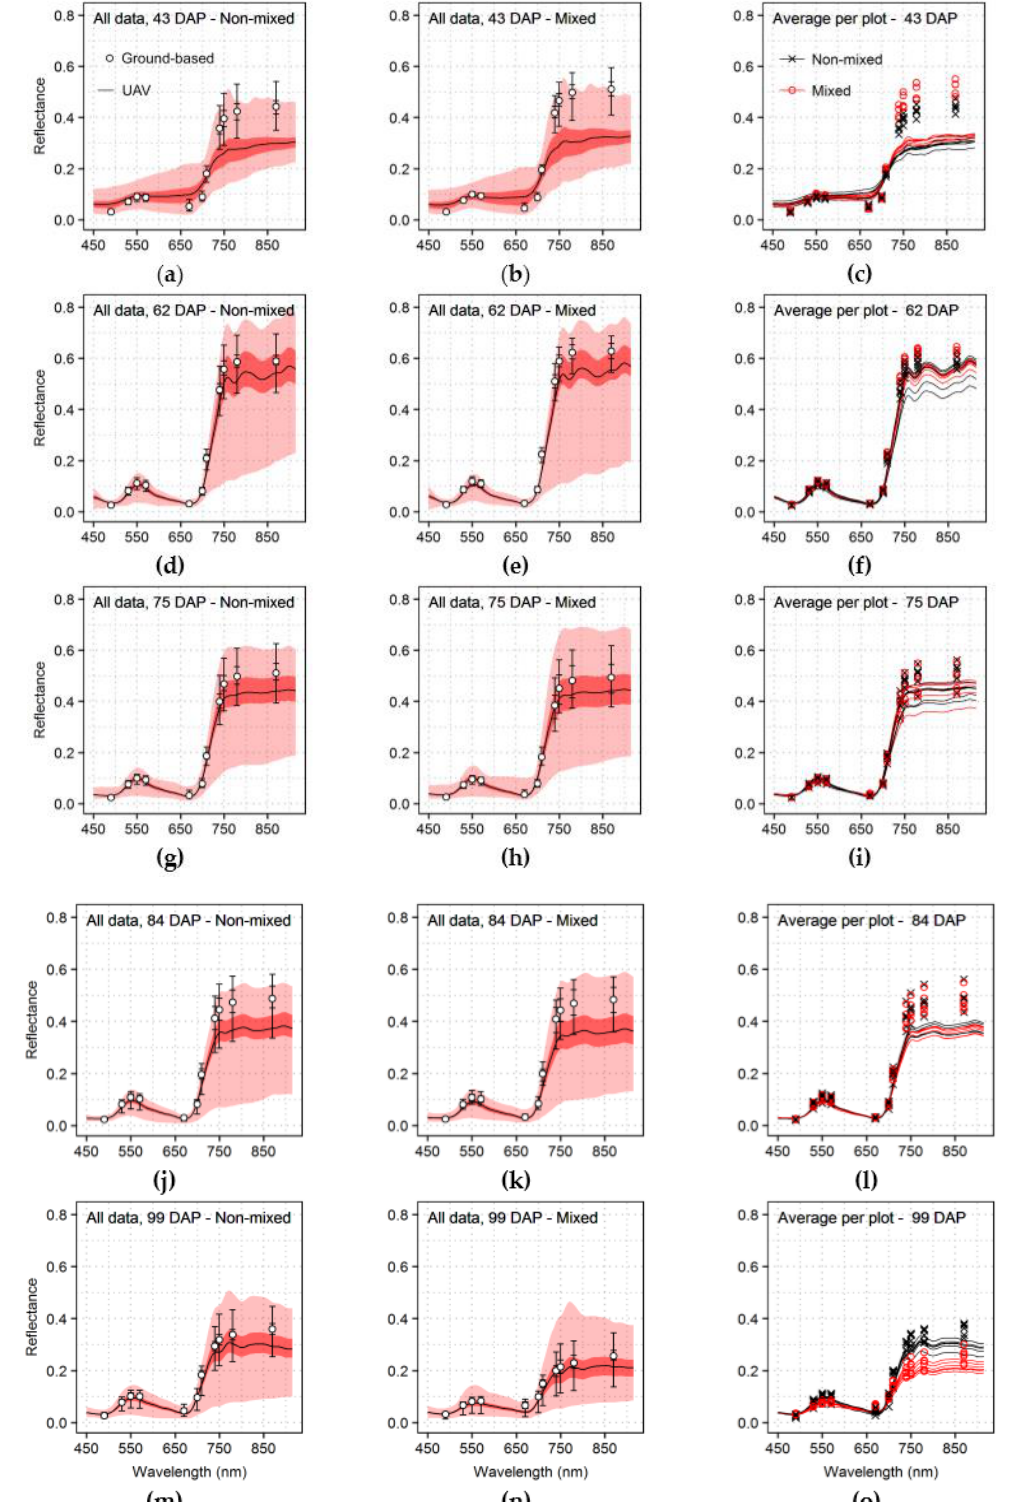
Figure 5. Description of the spectra acquired using ground-based (dots) and UAV sensor (lines) for each production system (i.e., non-mixed and with mixed varieties) and acquisition date: ( a , b ) 43, ( d , e ) 62, ( g , h ) 75, ( j , k ) 84 and ( m , n ) 99 DAP. Data range (maximum and minimum values), 25% and 75% quartiles are represented using red shades for the complete UAV dataset and using error bars for all ground measurements. Graphs in last column ( c , f , i , l , o ) correspond to the averaged reflectance for plots of both cultivation methods.